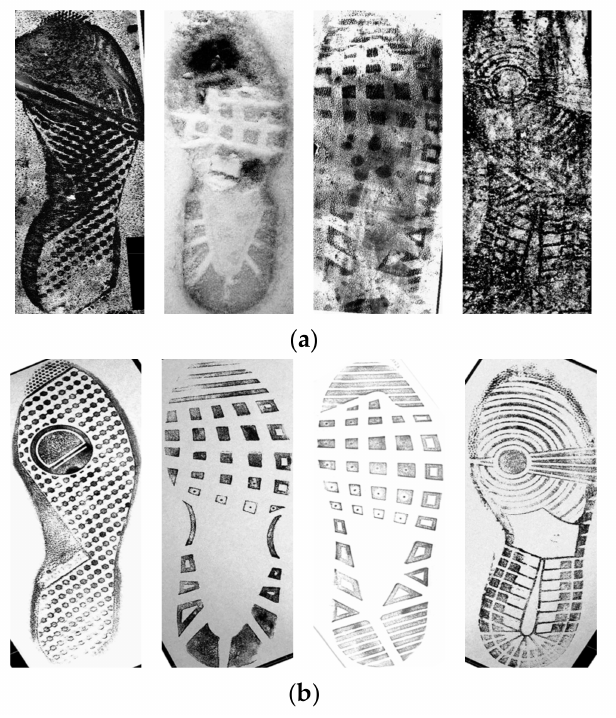
Figure 8. Sample shoeprints in the FID-300 dataset: ( a ) The query shoeprint collected at crime scenes. ( b ) The corresponding shoeprints of the query